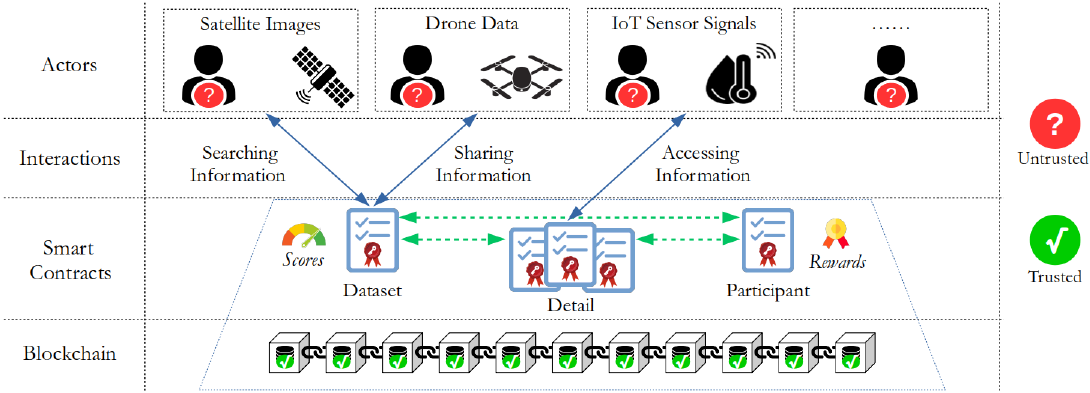
Figure 2. Structure of the proposed